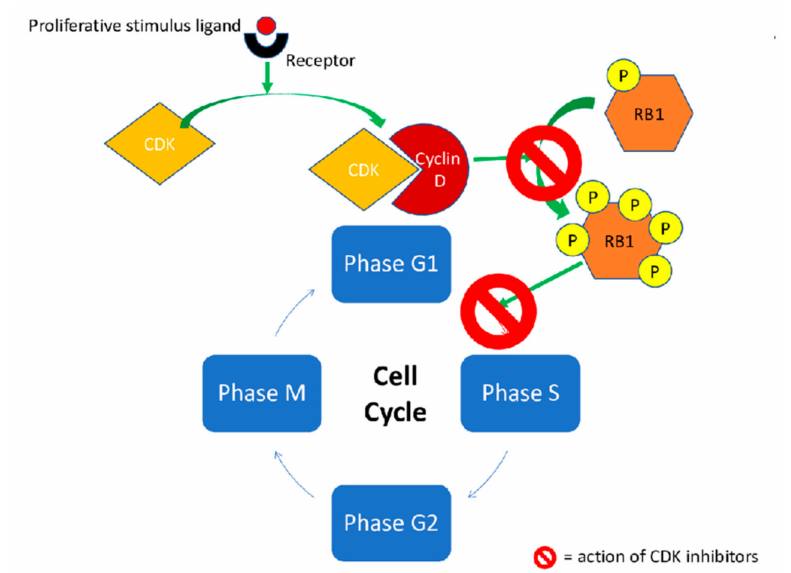
Figure 1. In red the enzymatic reactions prevented by CDK inhibitors are shown. Physiologically, growth signals induce the expression of Cyclin D which binds CDK4 or CDK6; this CDK-Cyclin complex promotes the hyper-phosphorylation of the tumor suppressor protein RB1 which is bound to the E2F transcription factor, determining its release and the consequent expression of genes implicated in cellular entry in S phase and proliferation, as topoisomerase-II α . The hyper-expression of Cyclin D is shown in hyper-activatedcellularsignaling, involvedinthe oncogenesisofseveral tumors, as RAS / RAF / MEK / ERK and PI3K / AKT / mTOR pathways. When CDK inhibitors are used, the hyper-phosphorylation of the RB1 by complex CDK-Cyclin D and the consequent transcription of important enzymes allowing the transition from G1 to S phase of cell-cycle, such as topoisomerase-Ii α , are prevented. CDK—Cyclin Dependent Kinase; RB1—RB transcriptional corepressor 1; P—Phosphate